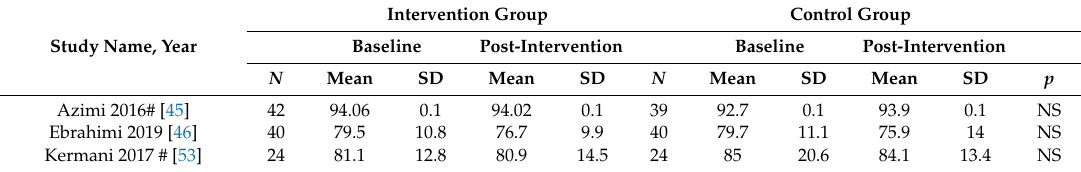
Table 9. Summary of findings for diastolic blood pressure (DBP).